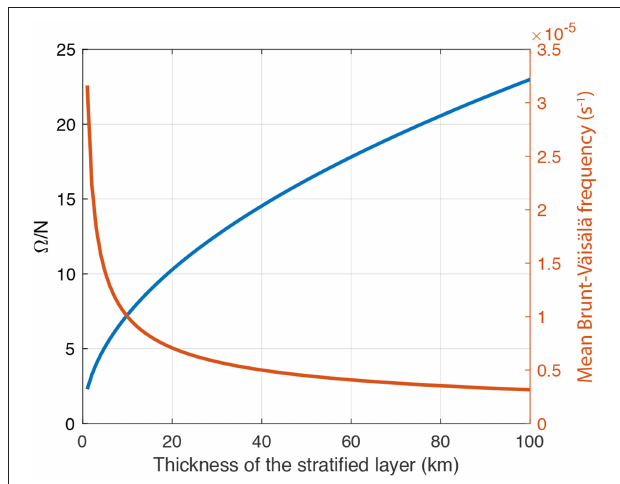
FIGURE 12 | Mean Brunt-Väisälä frequency (orange) and N /(cid:127) ratio (blue) obtained when spreading linearly a density difference 1ρ across a stratified layer of given thickness ( x -axis), for 1ρ/ρ